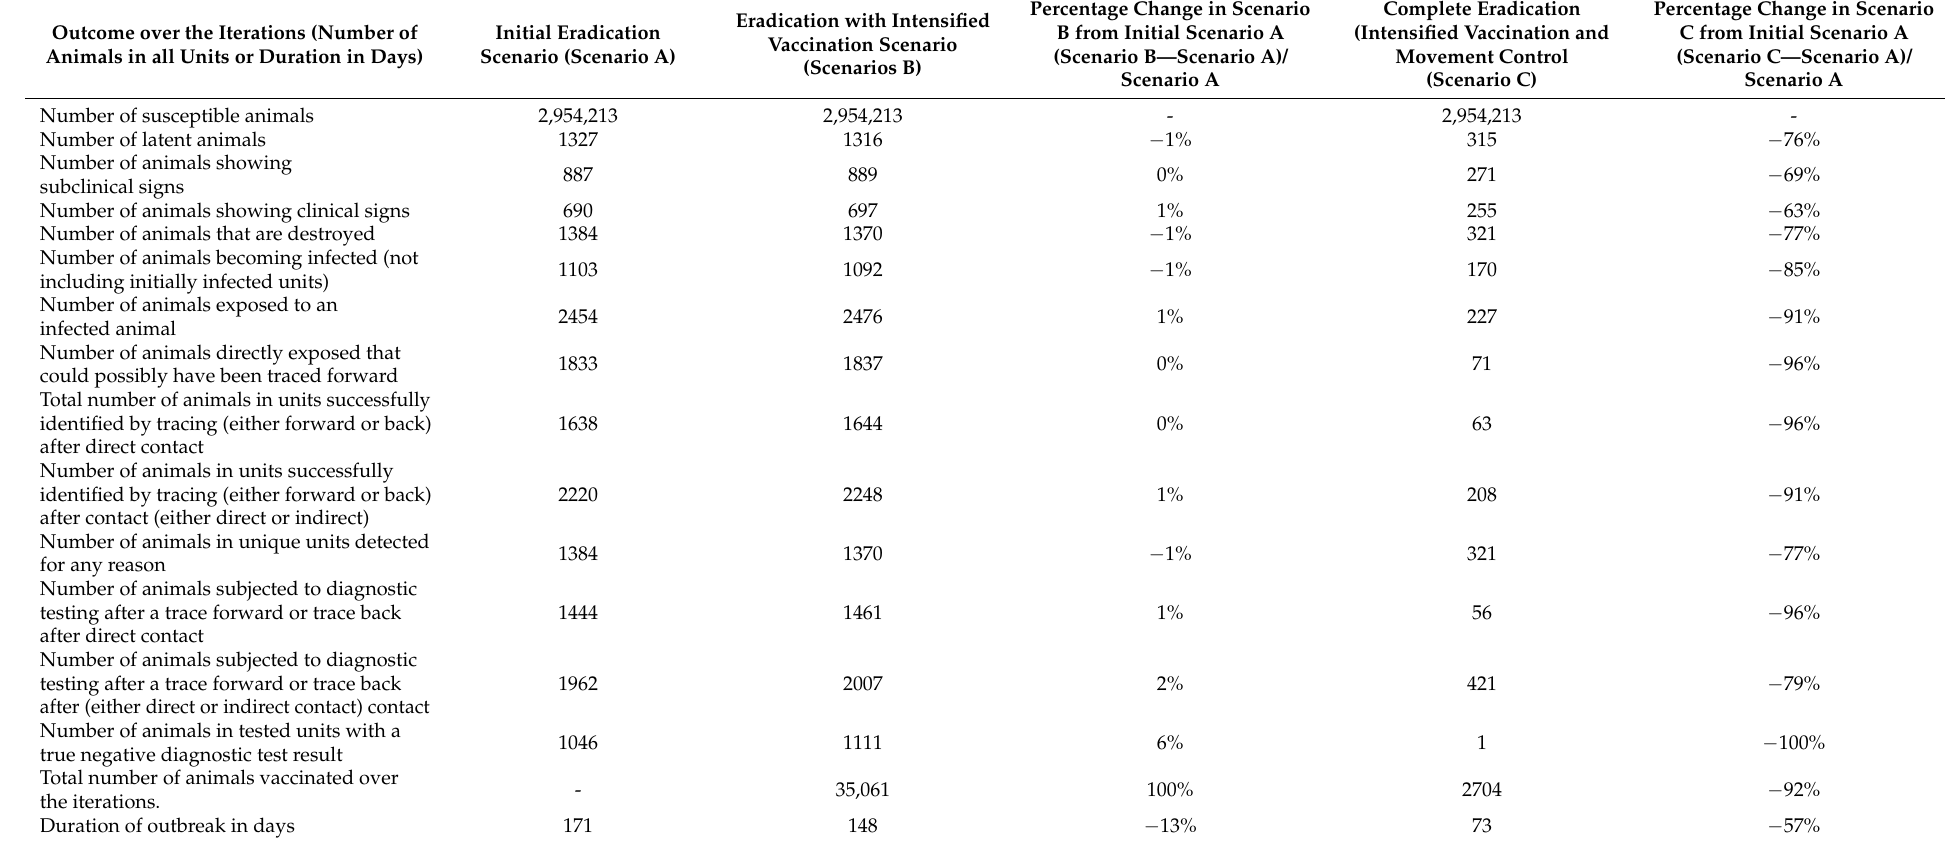
Table 2. Simulation scenarios’